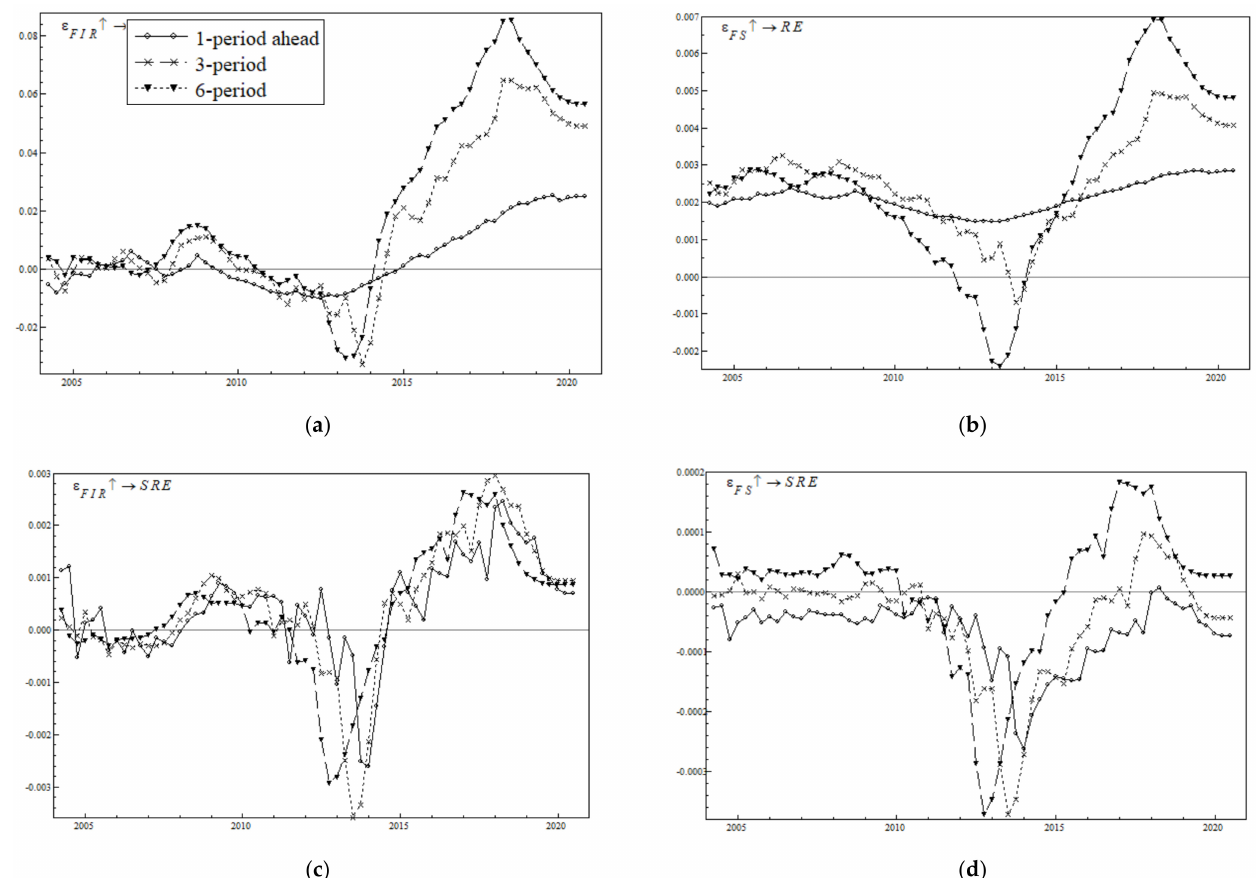
Figure 3. Time-varying impulse response diagram of different lag periods. ( a ) The response function of RE to FIR; ( b ) the response function of RE to FS; ( c ) the response function of SRE to FIR; and ( d ) the response function of SRE to